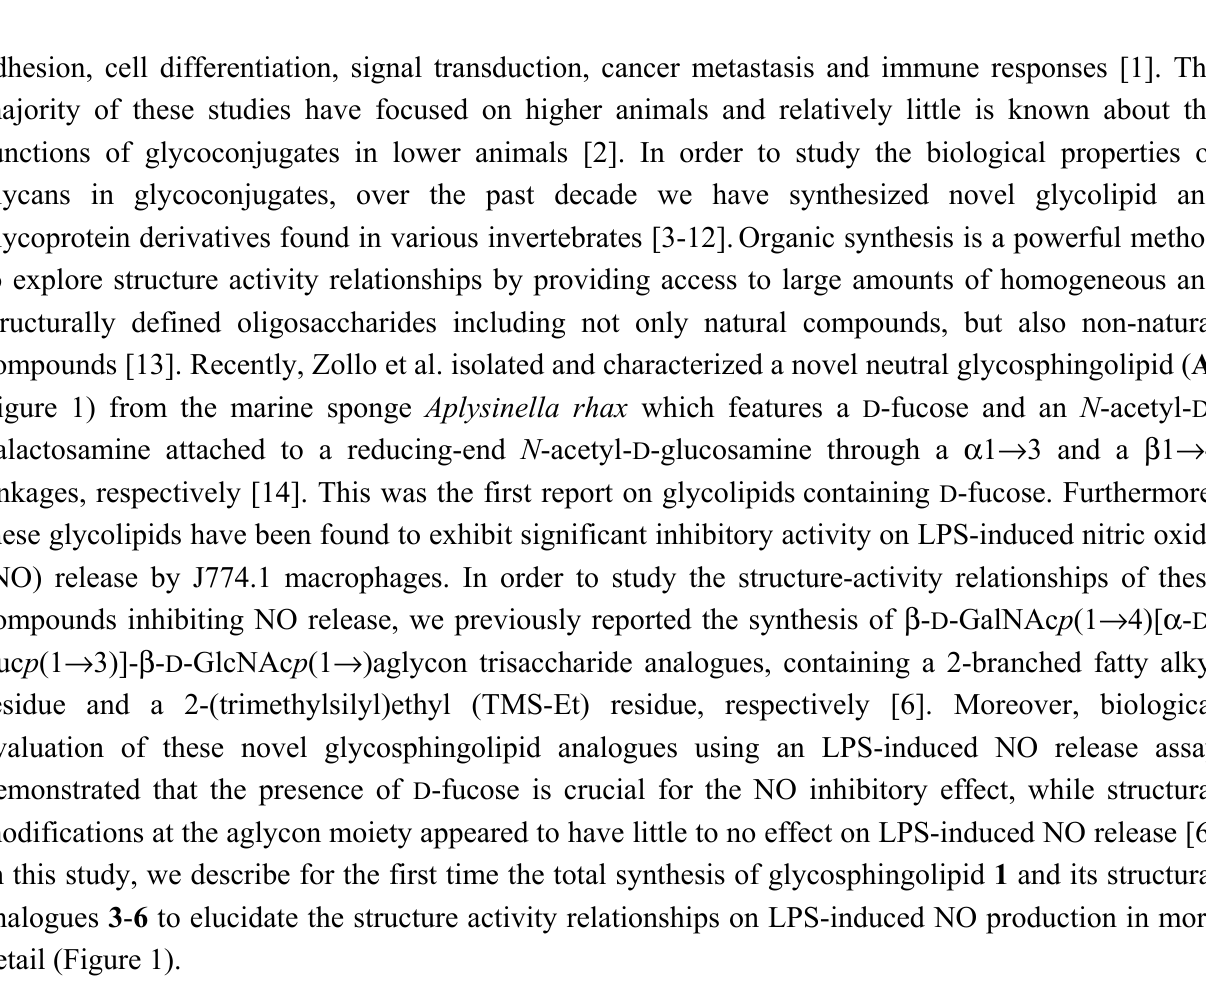
Figure 1. Target glycosphingolipid and the analogue